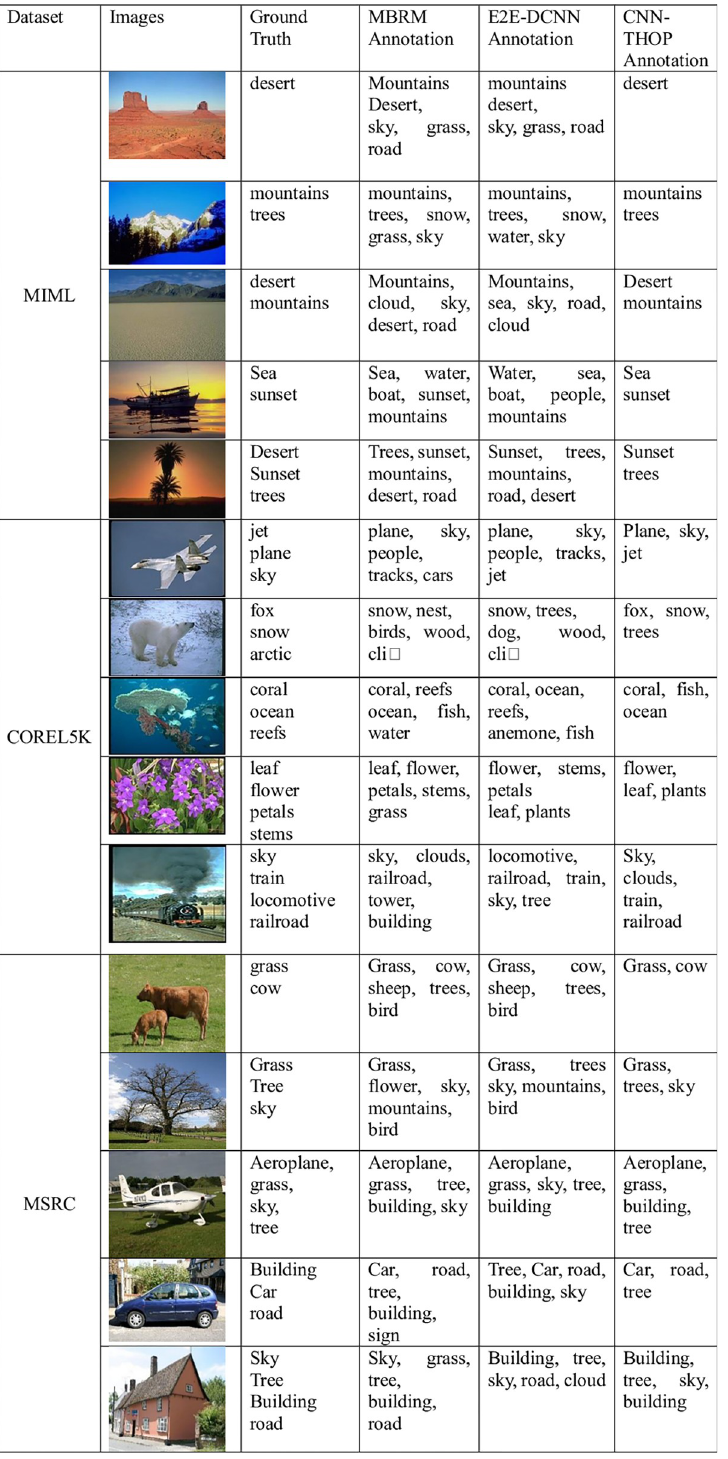
PLOS ONE | https://doi.org/10.1371/journal.pone.0238956 September 23,